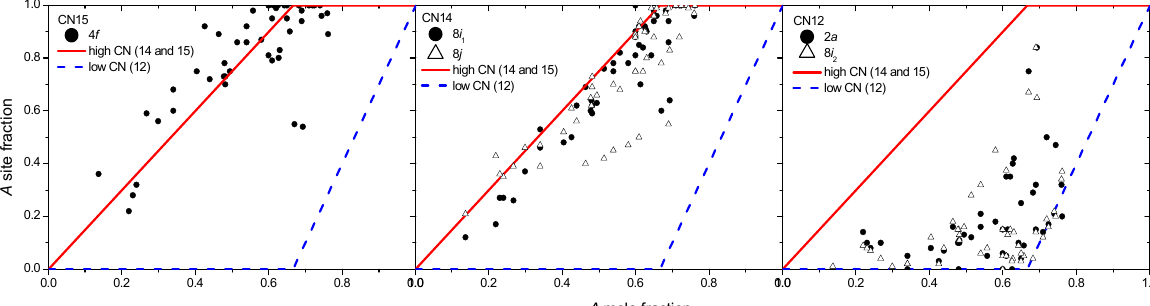
Figure 3. Experimental site occupancies for the σ phase in all the studied systems (redrawn from [22]). The ideal scheme to describe the experimental data is drawn with